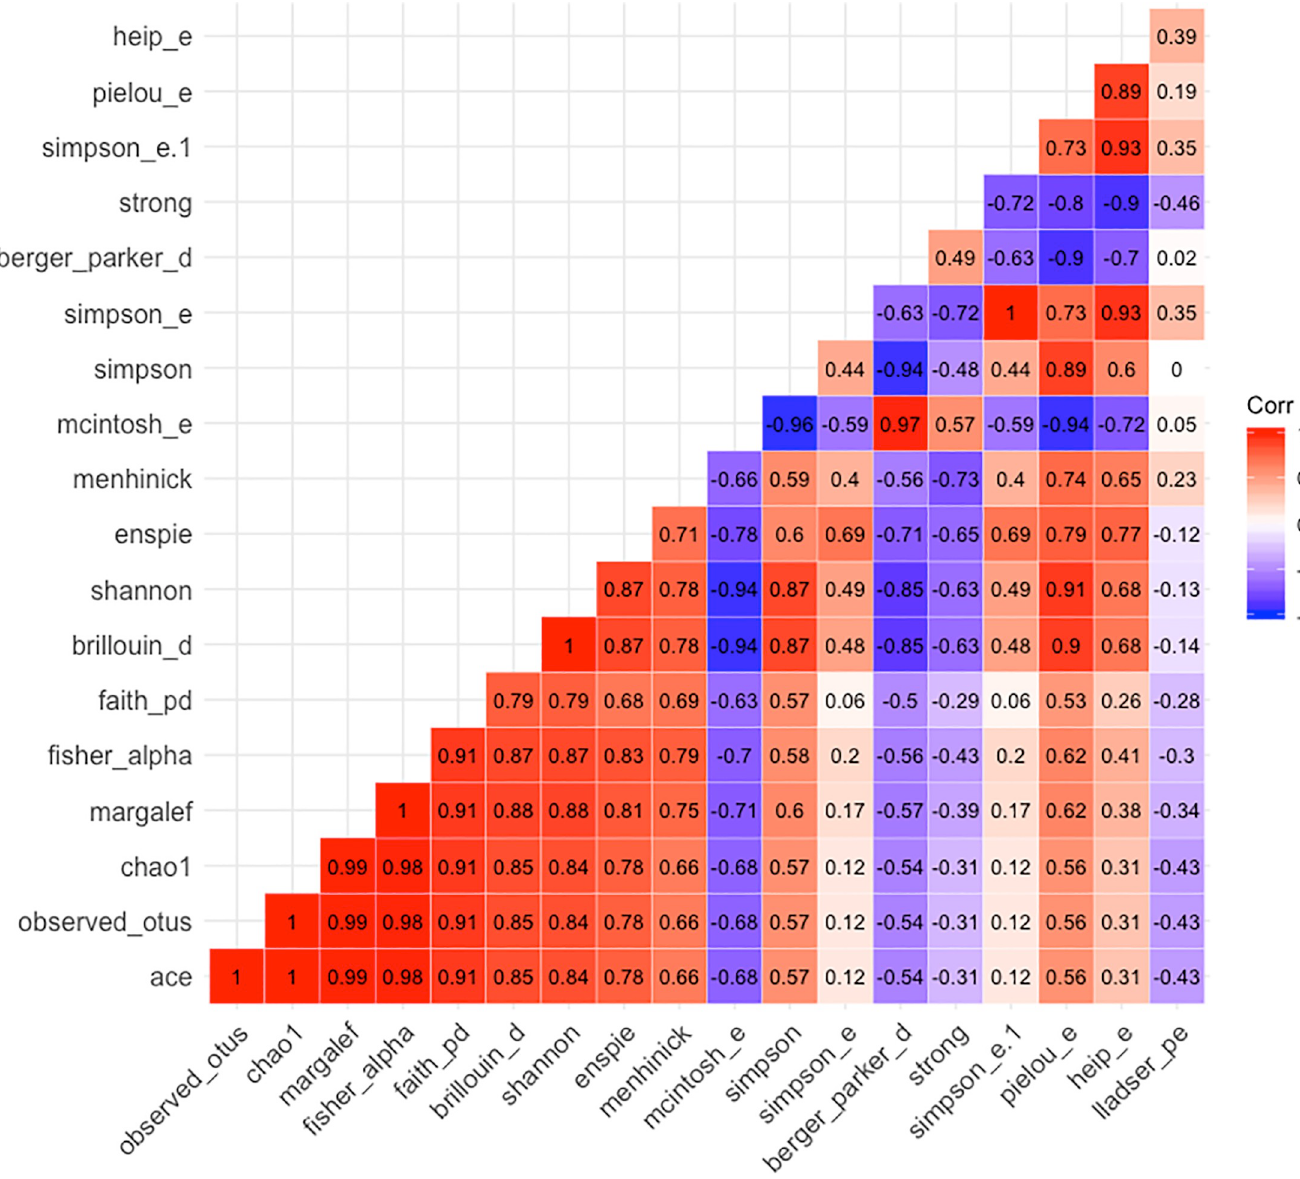
PLOS ONE | https://doi.org/10.1371/journal.pone.0229204 March 2,